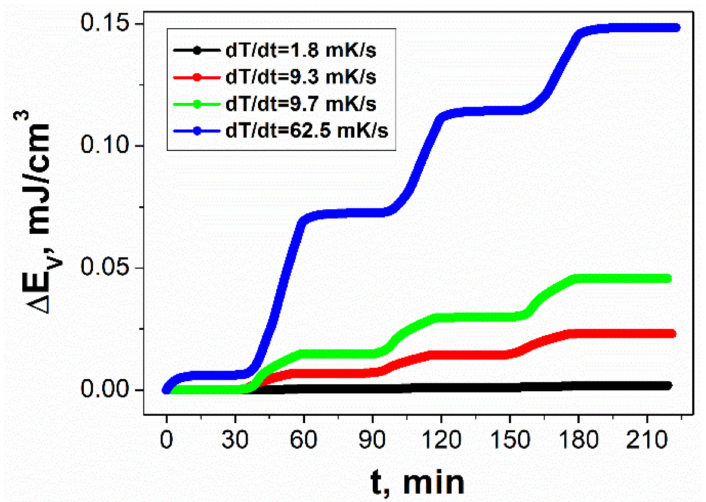
Figure 7. Volume energy density generated by the SbSI–TiO 2 device during three periodic